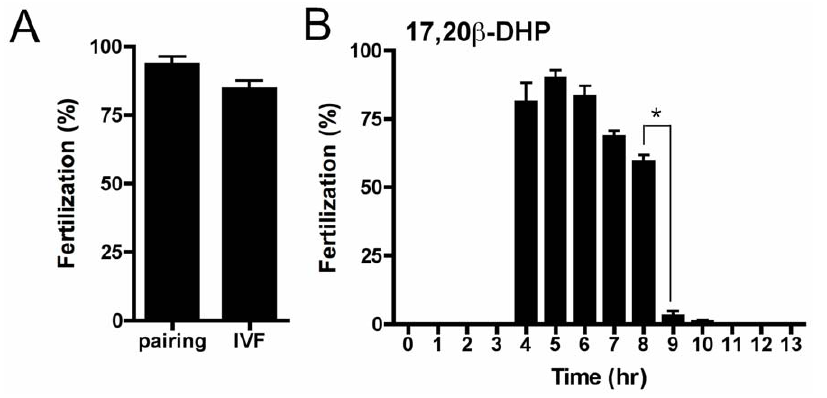
Figure 4. Externally applied 17,20 b -DHP induced natural spawning. (A) Fertilization rates were compared between eggs squeezed from females treated with in vivo 17,20 b -DHP and eggs resulting from normal pairing. Three spawning pairs of zebrafish were selected by standard pairing techniques and checked for fertilization rate. Several days after spawning, when ready for their next spawning event, females were treated with 17,20 b -DHP and artificial fertilization conducted upon squeezed eggs using sperm obtained from the paired males. (B) Treatment of more than thirty female zebrafish with 17,20 b -DHP in vivo began at time zero. During incubation, three females were selected and artificial fertilization conducted for eggs squeezed at each time point. Fertilization rates were assessed by counting the proportion of eggs dividing into the 4-cell stage after fertilization. Each value represents the mean of data from three different females. Vertical lines indicate standard deviation.